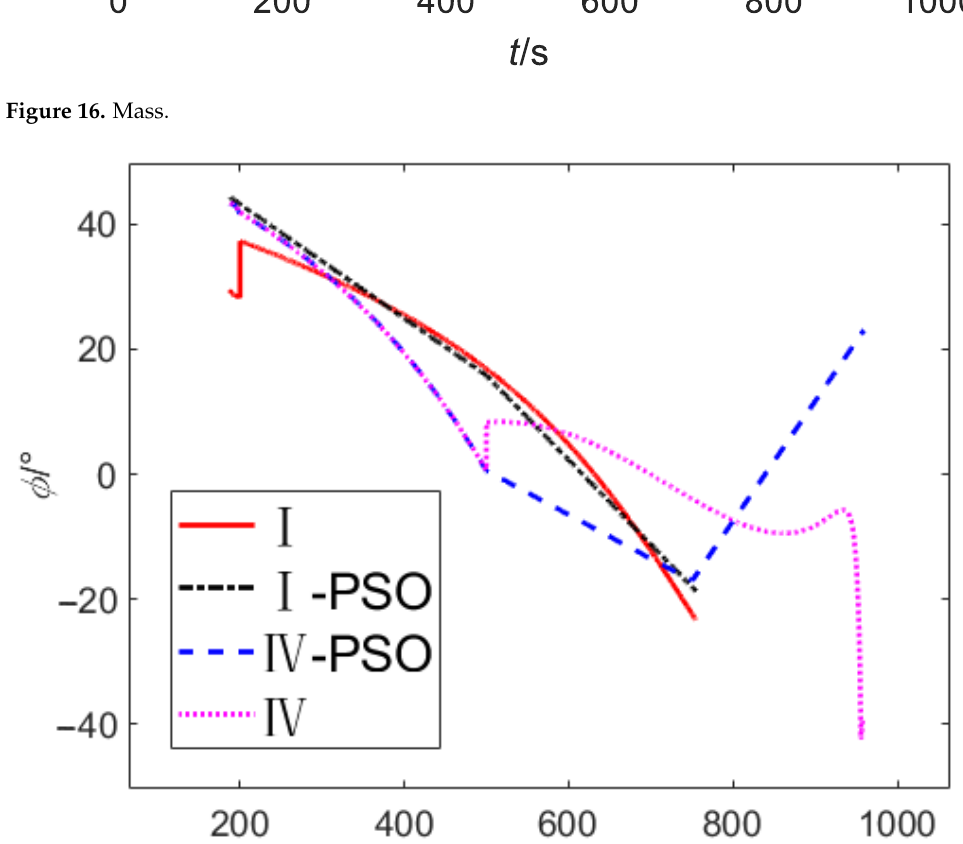
Figure 17. Pitch Figure 17. Pitch angle. Figure 17. Pitch angle.